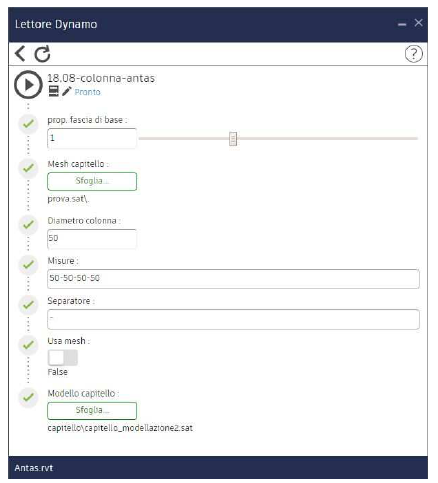
Figure 10. Dynamo player interface for entering the parameters by the